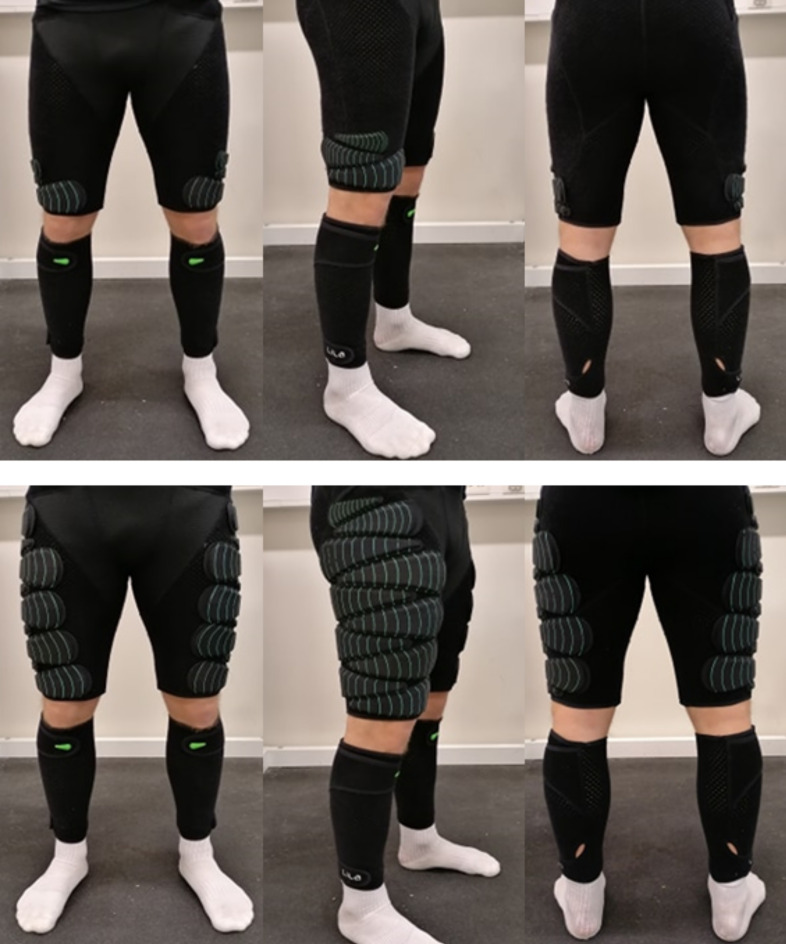
Illustration of 1 and 5% BM resistance with thigh condition for a 70 kg football player.